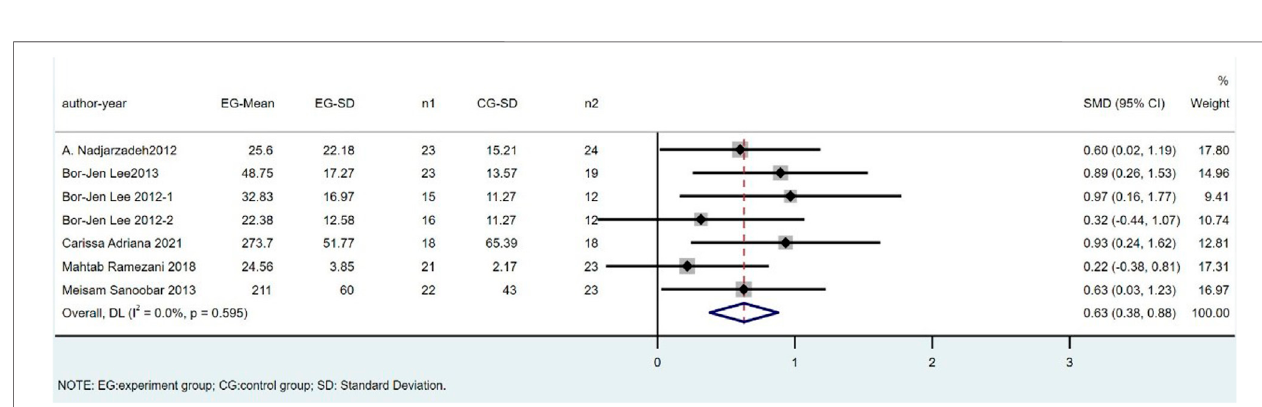
FIGURE 3 | Meta-analysis of studies investigating the effect of CoQ10 supplements use on MDA level.